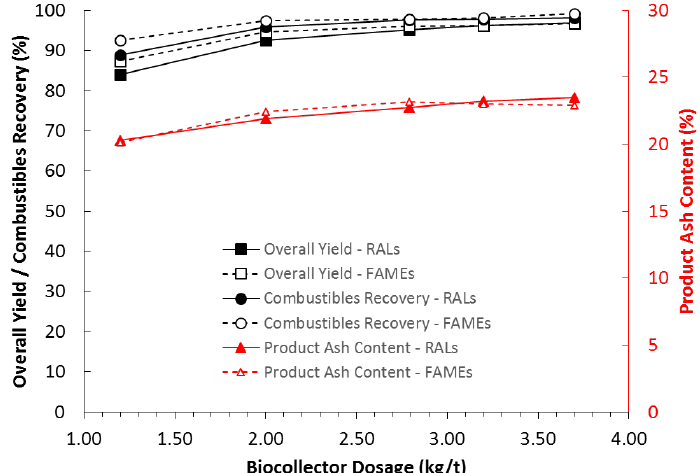
Figure 8. Overall yield, combustibles recovery and product ash content for Site 2 flotation experiments as a function of biocollector dosage at pH 2.7.